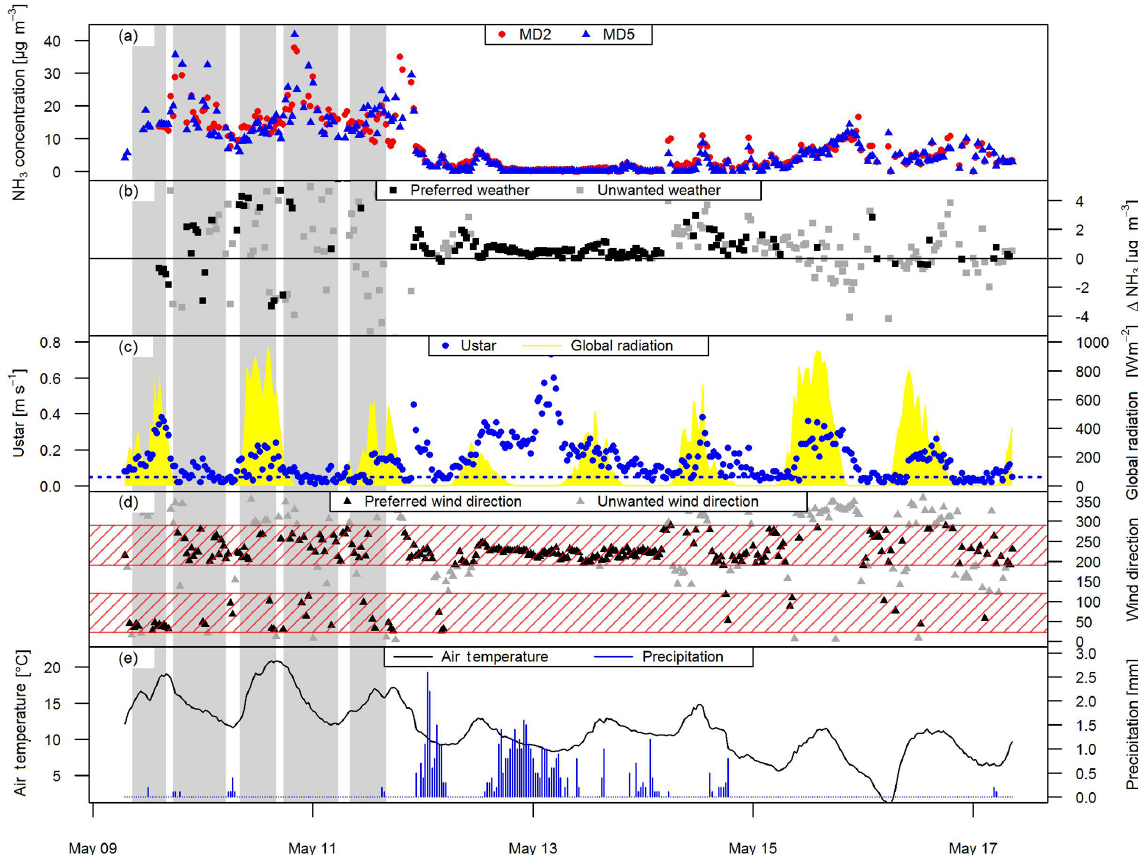
Figure 4. Time series of (a) MD concentration measurements (MD2 and MD5) on pasture system M and (b) the corresponding difference in concentration. The concentration differences during good wind conditions are shown in black, while grey indicates concentration differences during undesirable weather conditions. (c) Time series of u ∗ and global radiation. The blue dashed line indicates the 0.05ms − 1 u ∗ threshold. (d) Time series of wind direction. Wind direction values overlapping the preferred wind sector (avoiding sector A and B; Fig. 2) are shown in black. The preferred wind sectors are indicated by the red area. (e) Time series of air temperature and precipitation. The grey shaded area indicates grazing on the paddocks between MD2 and